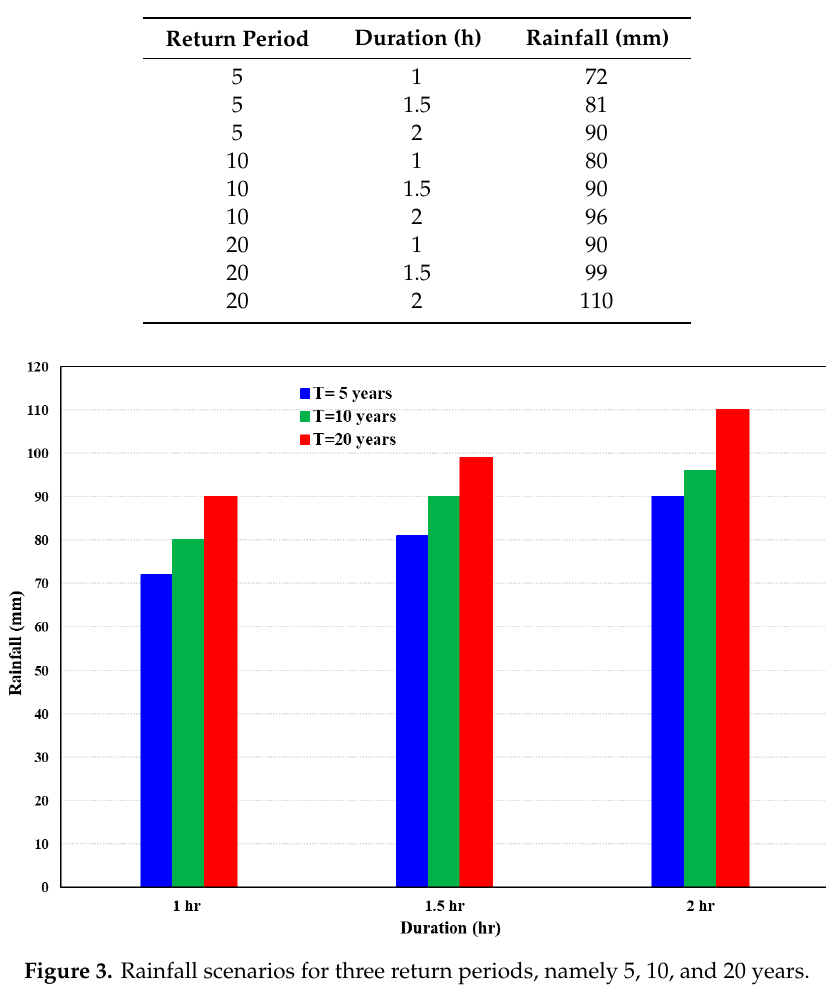
Table 1. Rainfall scenarios for three return periods and three durations.